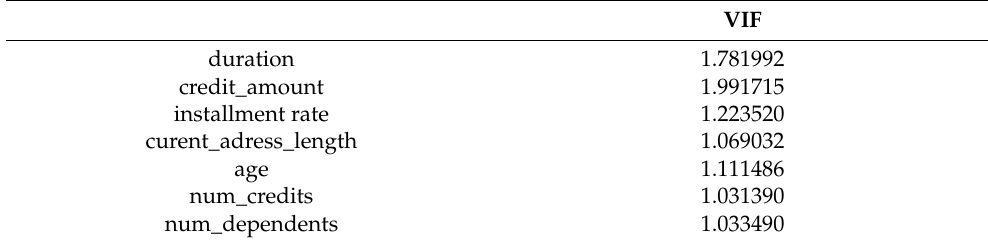
Table 9. VIF for model